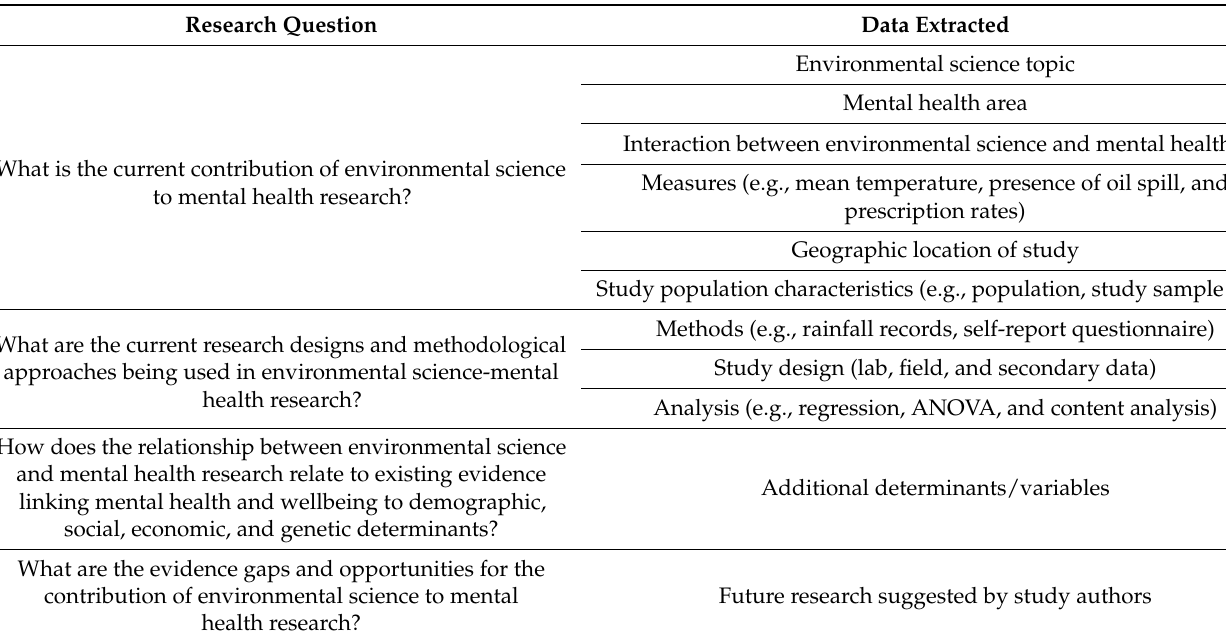
Table 2. Data charted by research